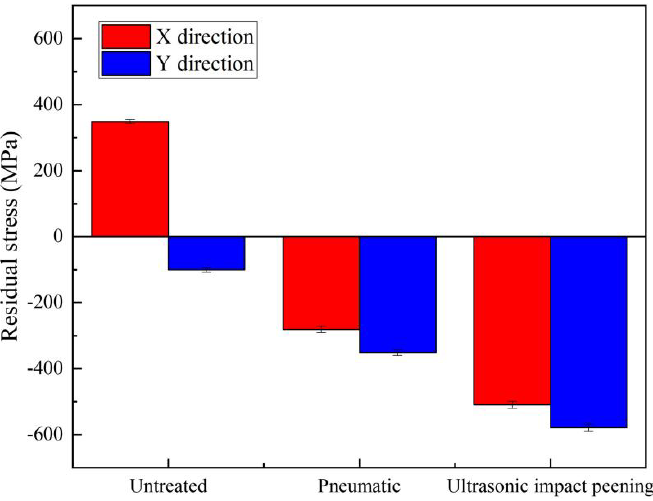
Figure 2. Microstructure of DSS 2205 weld seam area with different treatment methods.